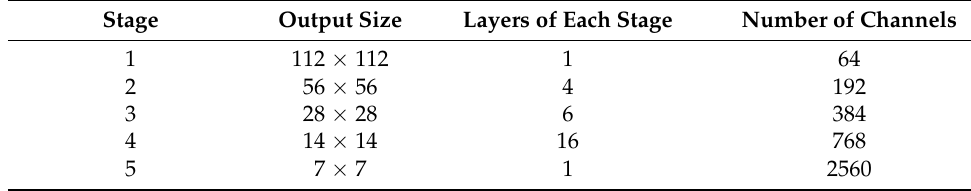
Table 3. Structure of RepVGG B3g4 network.